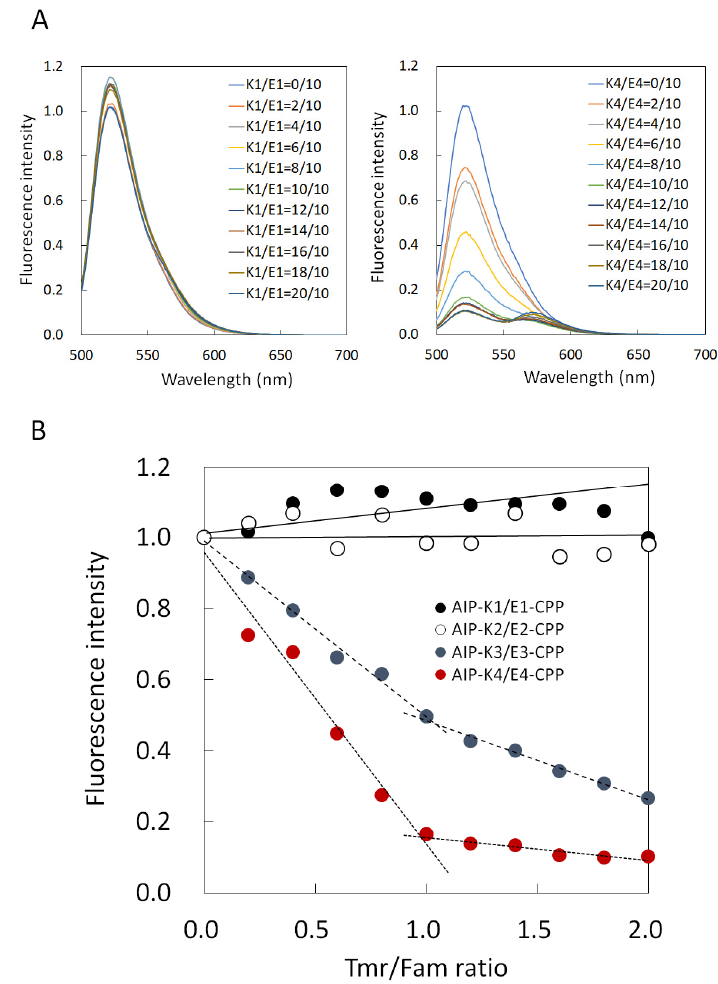
Figure 2. ( A ) Fluorescence spectra of E1-CPP (left panel) and E4-CPP (right panel) with various concentrations of AIP-K1 and AIP-K4, respectively. Fluorescence spectra of AIP-K2/E2-CPP and AIP-K3/E3-CPP are shown in Figures S17 and S18 in the Supplementary Materials. ( B ) Titration curves of fluorescence intensity at 525 nm for Tmr/Fam (AIP-Kn/En-CPP) ratios (n = 1, 2, 3, and 4 represented by black filled squares, black open squares, blue filled circles, and red filled circles, respectively).